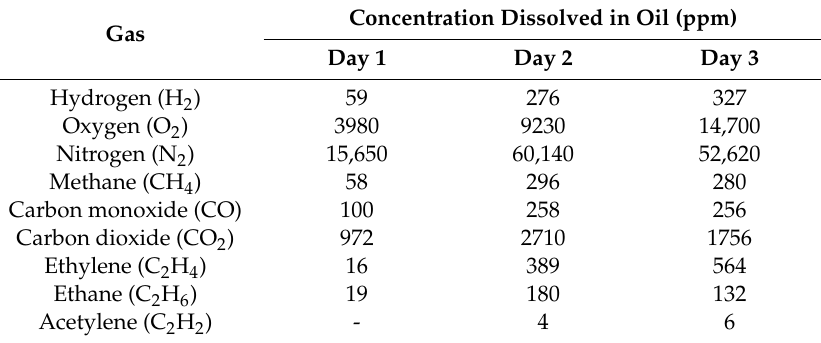
Table 4. Gases dissolved in oil.